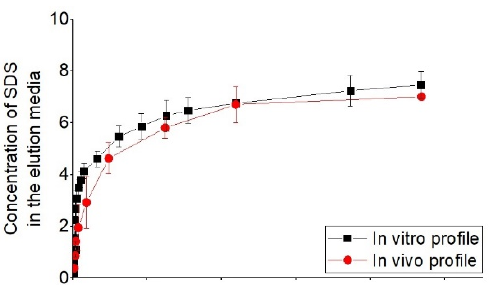
Figure 15. Comparison of the in vitro and in vivo profiles with time-scaling factor, reprinted from [56]. The parameters chosen for the in vitro test were as follows: test apparatus (USP 4); elution medium was an organic solvent; flow circulation of 25 mL/min; pH about 4.5; and temperature of 37 ◦